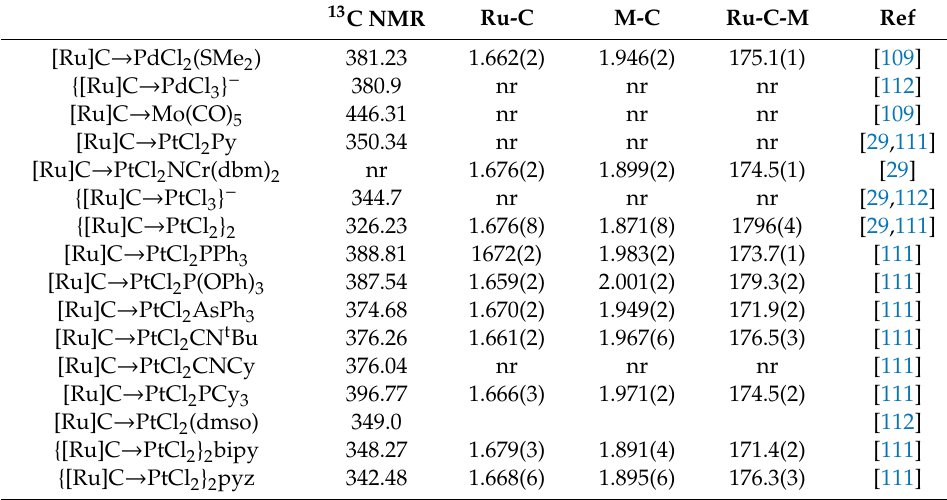
Figure 22. Spezification of ligands of Table 14. Table 14. Selected structural (in Å and deg) and spectroscopic ( 13 C NMR in ppm) details of [Ru]C addition